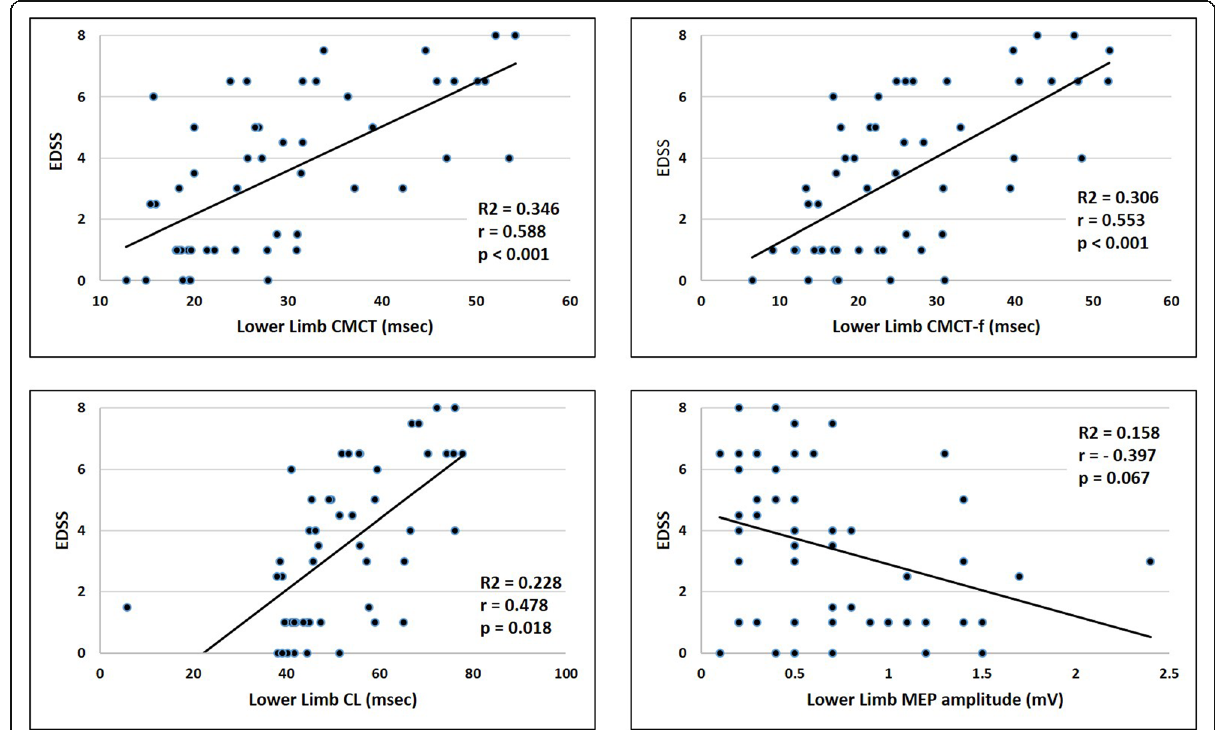
Fig. 2 Relationship of EDSS and lower limb CMCT (upper left), CMCT-f (upper right), CL (lower left), and MEP amplitude (lower